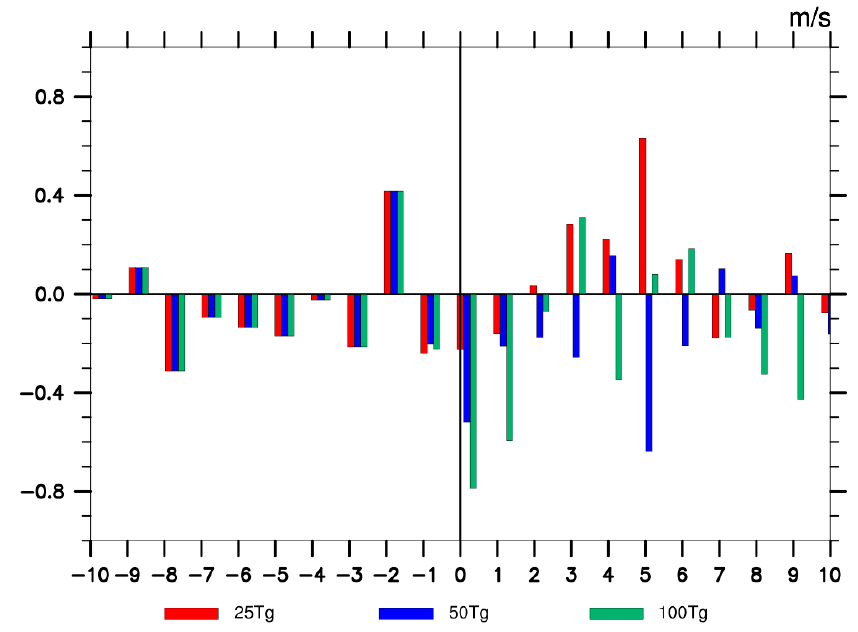
Figure 4. Changes of the Eastern Asian summer monsoon index (EASMI) before and after the years of volcanic eruptions with magnitudes of 25 Tg (red), 50 Tg (blue), and 100 Tg (green), respectively.